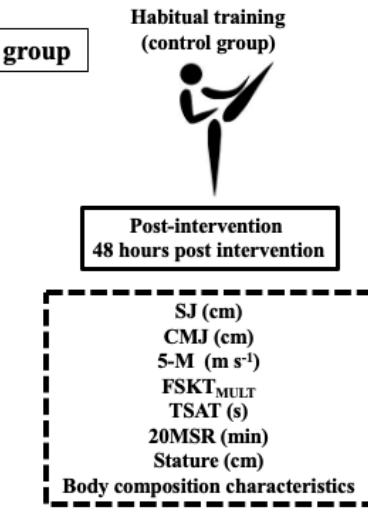
Figure 2. Training protocol. SJ: squat jump; CMJ: countermovement jump; 5M: linear sprint in 5 m; FSKT MULT : multiple frequency speed of kick test; TSAT: taekwondo specific agility test; 20MSR: 20-metre shuttle